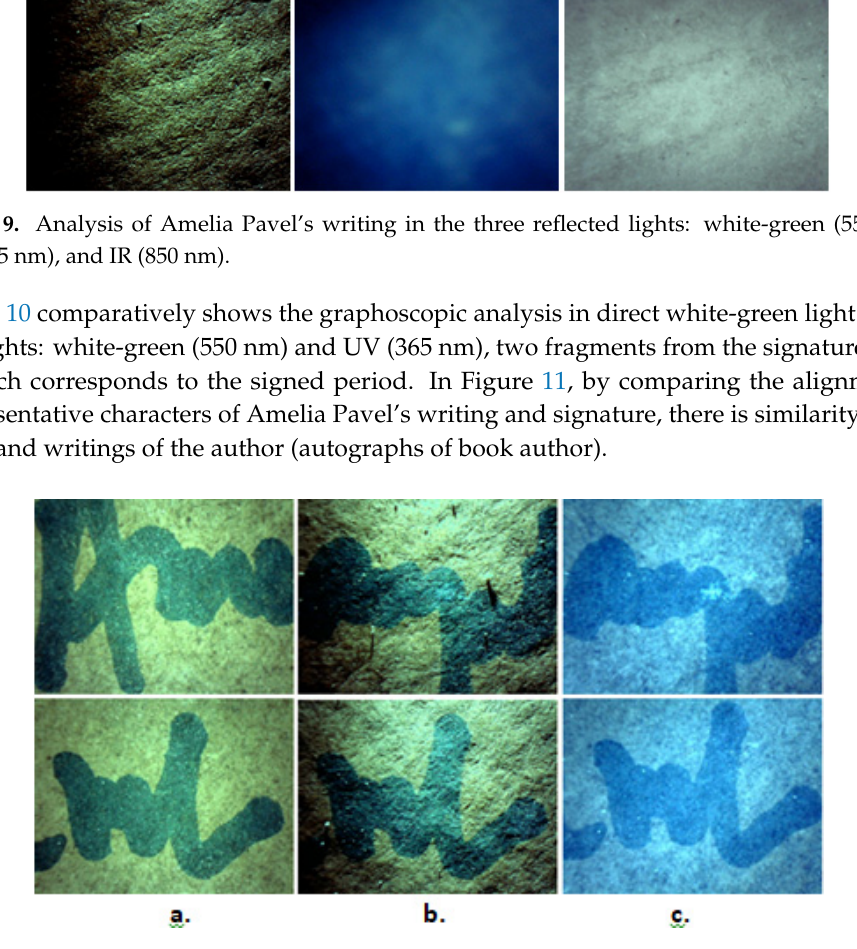
Figure 10. Fragments from Amelia Pavel’s signature in direct white-green light ( a ), compared with two reflected lights beams: white-green ( b ) and UV ( c ).